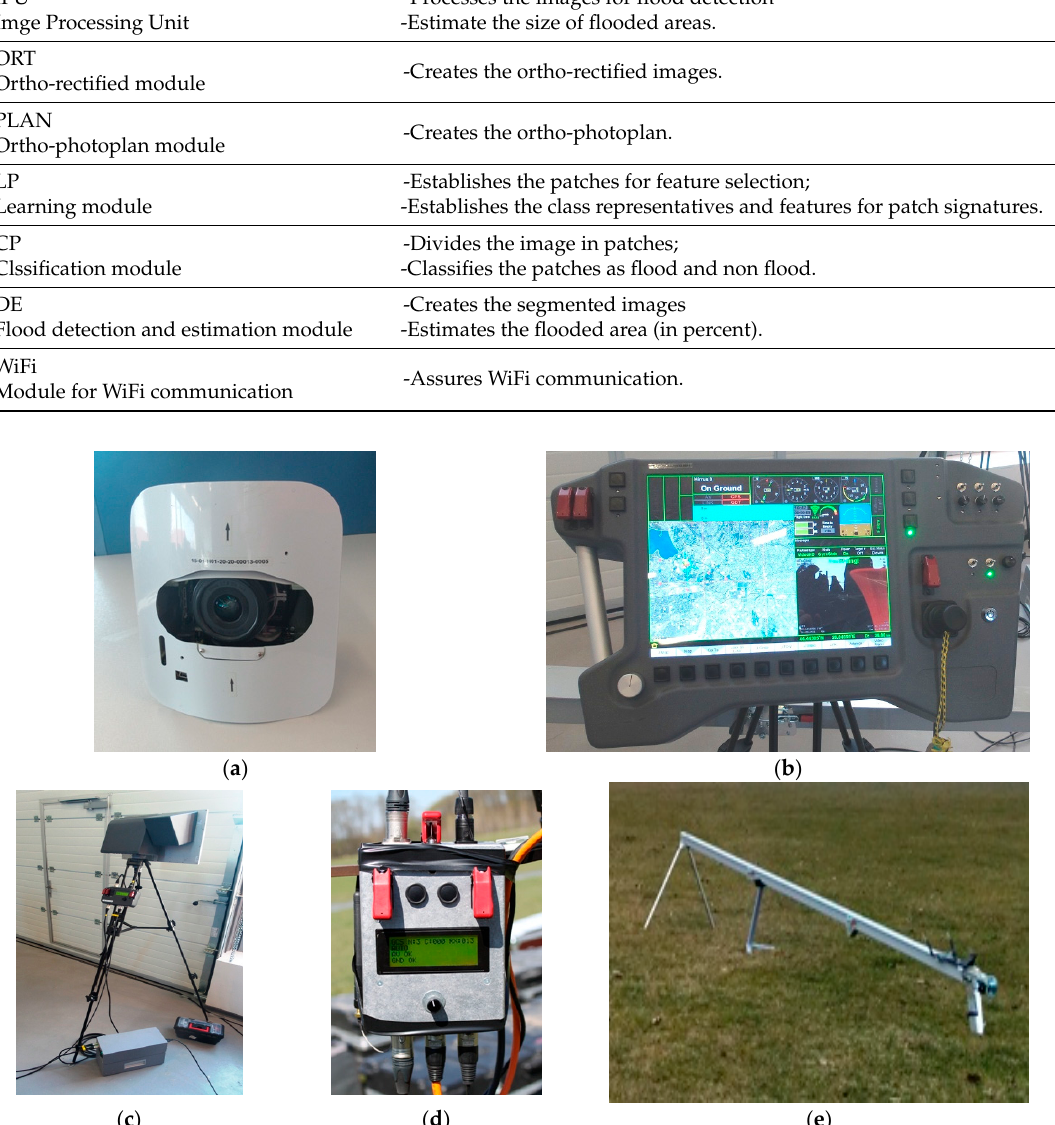
Figure 3. System components: ( a ) Payload photo; ( b ) GCS; ( c ) GDT; ( d ) ID box; ( e ) Launcher.